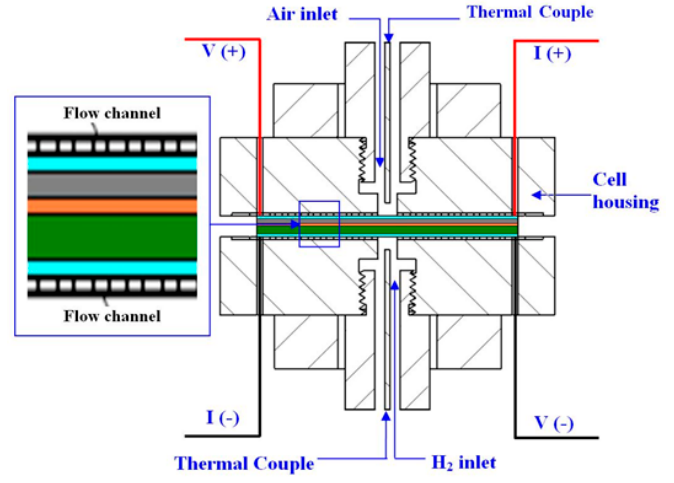
Figure 1. The schematic device of the SOFC test